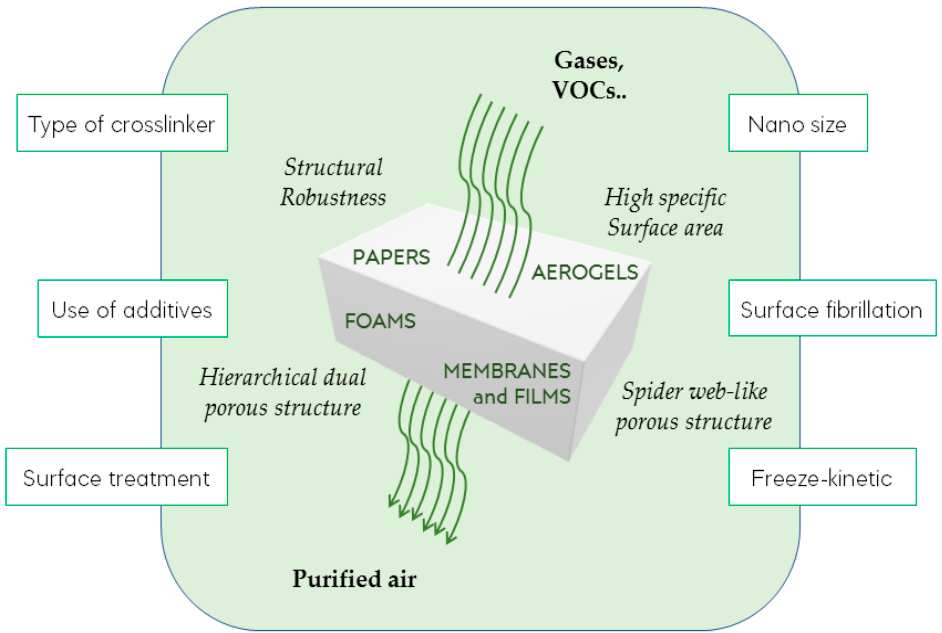
Figure 4. Summary depiction of the ideal characteristics that provide good filtering properties to a system, and of the general methodologies to achieve these